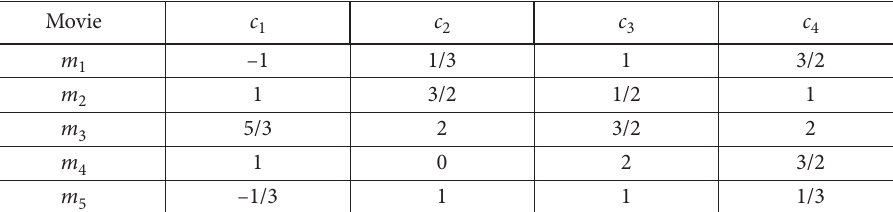
Table 2. Score function decision